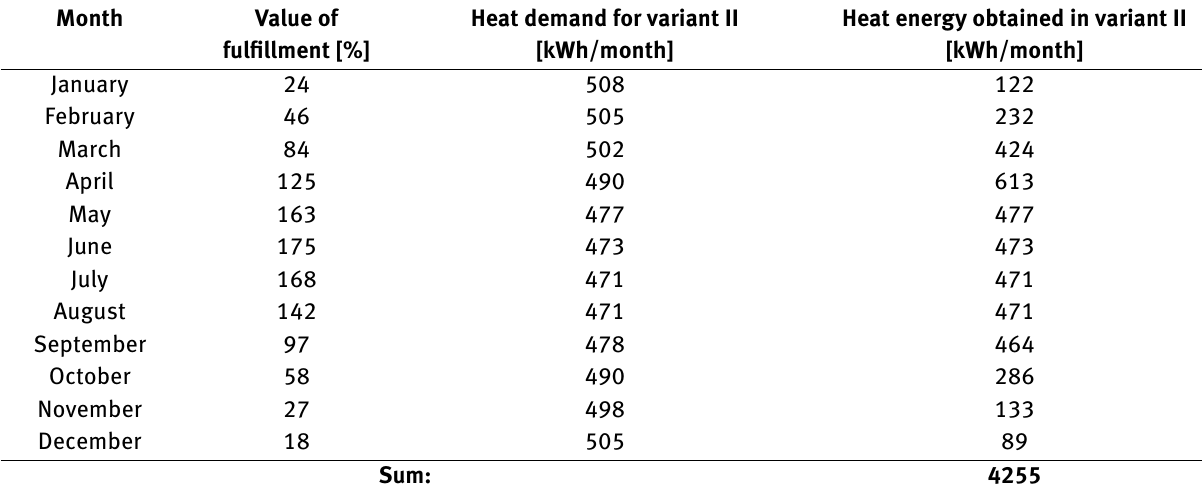
Table 9: Value of thermal energy obtained by the solar installation (Variant II)